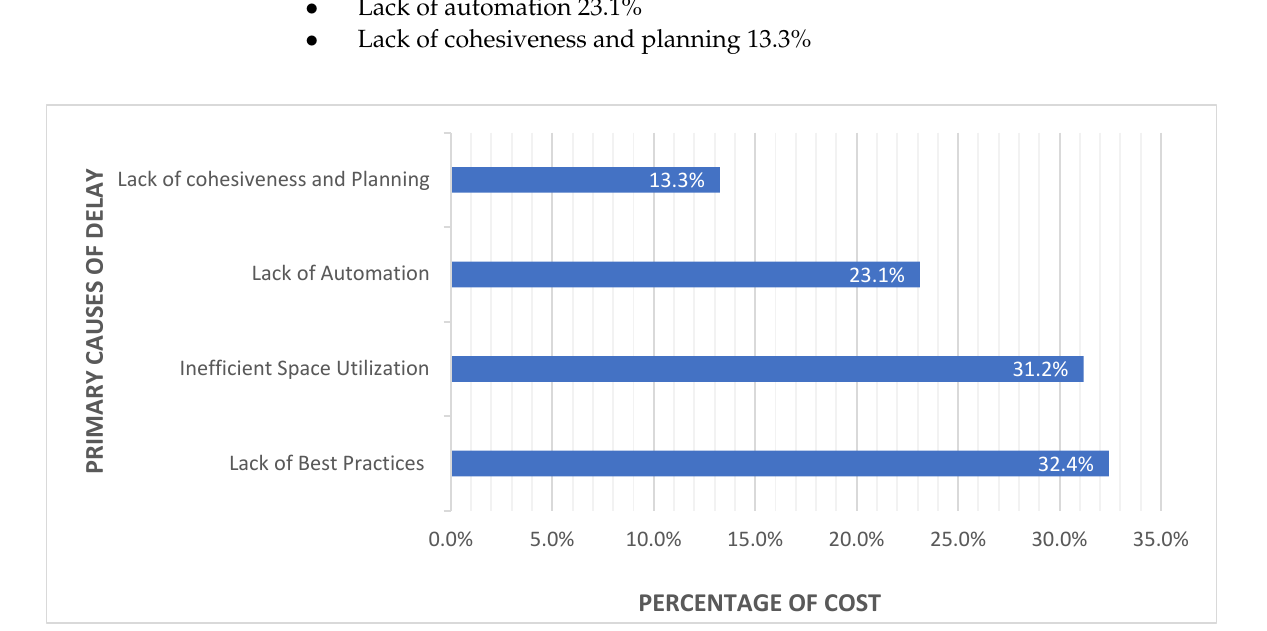
Figure 6. The primary causes of delay in relation to the percentage of cost—ophthalmic antihistamines and decongestants.